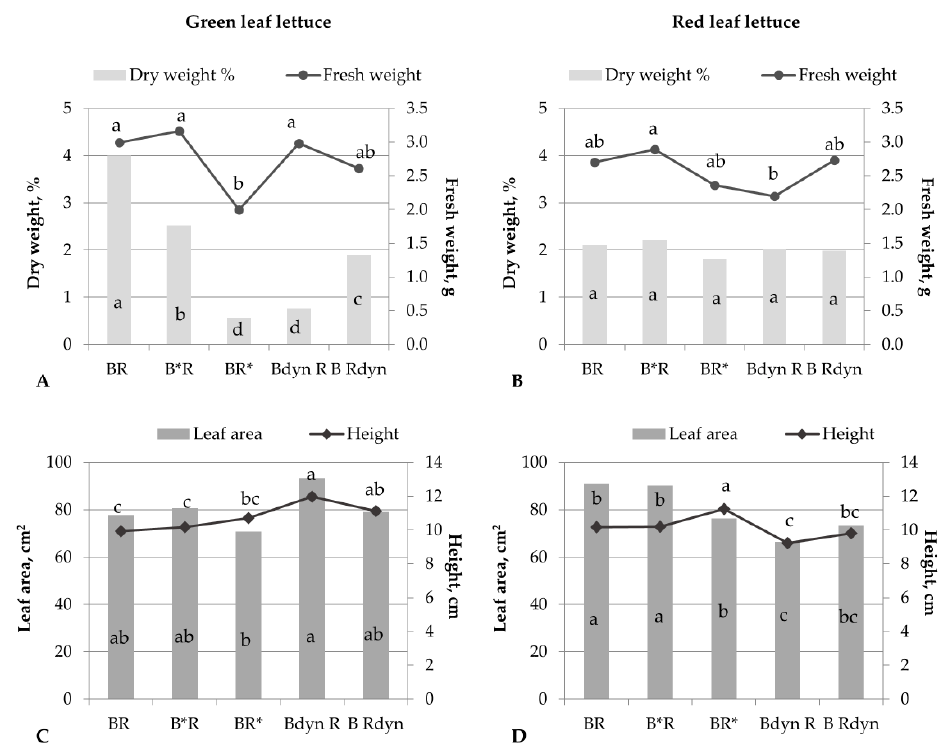
Figure 2. Biometric measurement results of red and green lettuce leaves, illuminated with constant and dynamic fluxes of red 662 nm and blue 452 nm light. ( A , B )—fresh weight and dry weight %, ( C , D )—lettuce height and leaf area. ( A , C )—green leaf lettuce. ( B , D )—red leaf lettuce. Di ff erent letters indicate statistically significant di ff erences between means according to the Duncan’s multiple range test at the confidence level p = 0.05. Table 2. Non-destructive measurement parameters in red and green lettuce leaves, illuminated with constant and dynamic fluxes of red 662 nm and blue 452 nm light. Fv / m—quantum e ffi ciency of PSII; NBI—nitrogen balance index. Di ff erent letters indicate statistically significant di ff erences between means according to the Duncan’s multiple range test at the confidence level p = 0.05.